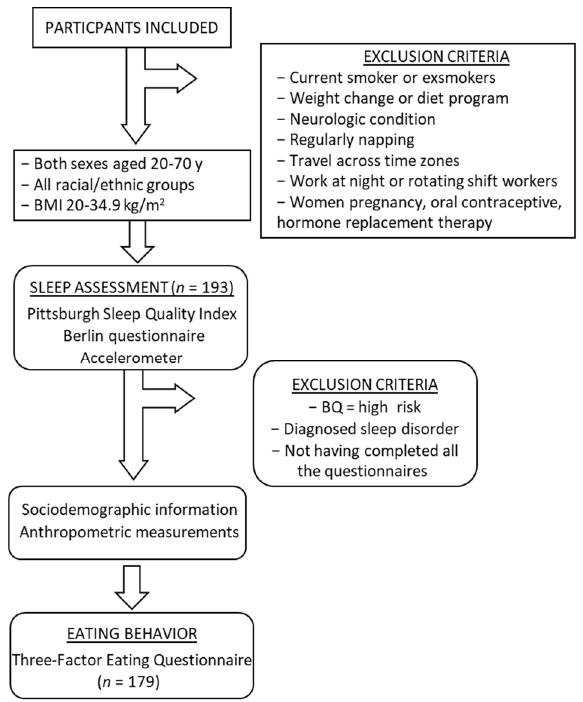
Figure 1. Flow chart of participant inclusion and exclusion criteria for the different measures included in the study. BMI: body mass index; PSQI: Pittsburgh Sleep Quality Index; BQ: Berlin Questionnaire.